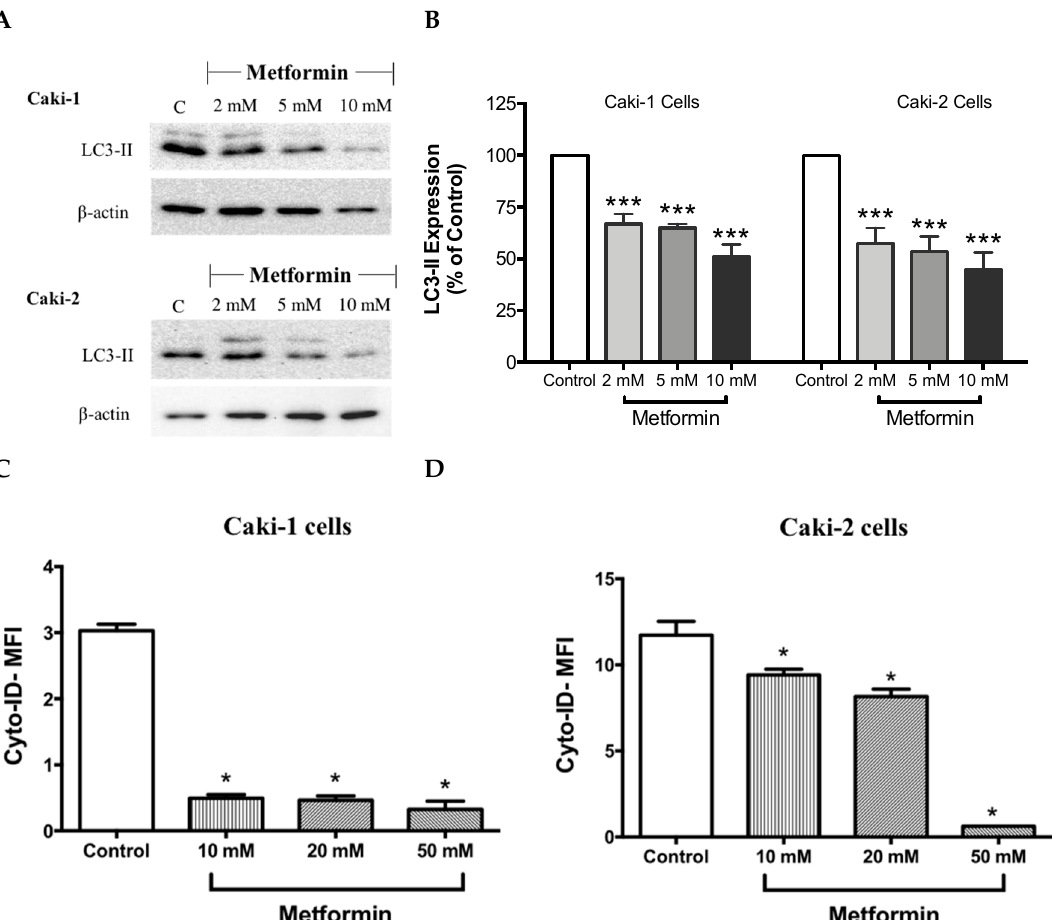
Figure 7. Metformin blunted autophagy induction in both Caki-1 and Caki-2 renal cancer cells. ( A ) Western blot analysis of LC3-II in Caki-1 and Caki-2 cells incubated in the absence (control) or presence of metformin (2, 5 and 10 mM). Images are representative of three independent experiments per group. ( B ) Histograms represent pooled densitometry data normalized to β -actin expressed as the percentage of control. Data are presented as mean ± SEM. Results of autophagy assessment by flow cytometry analysis using a Cyto-ID ® are shown for ( C ) Caki-1 and ( D ) Caki-2 cells. ( C , D ) Histograms represent pooled data from three independent experiments per group. Data are presented as mean ± SEM. * P < 0.05; ** P < 0.001; and *** P < 0.0001 vs. control.